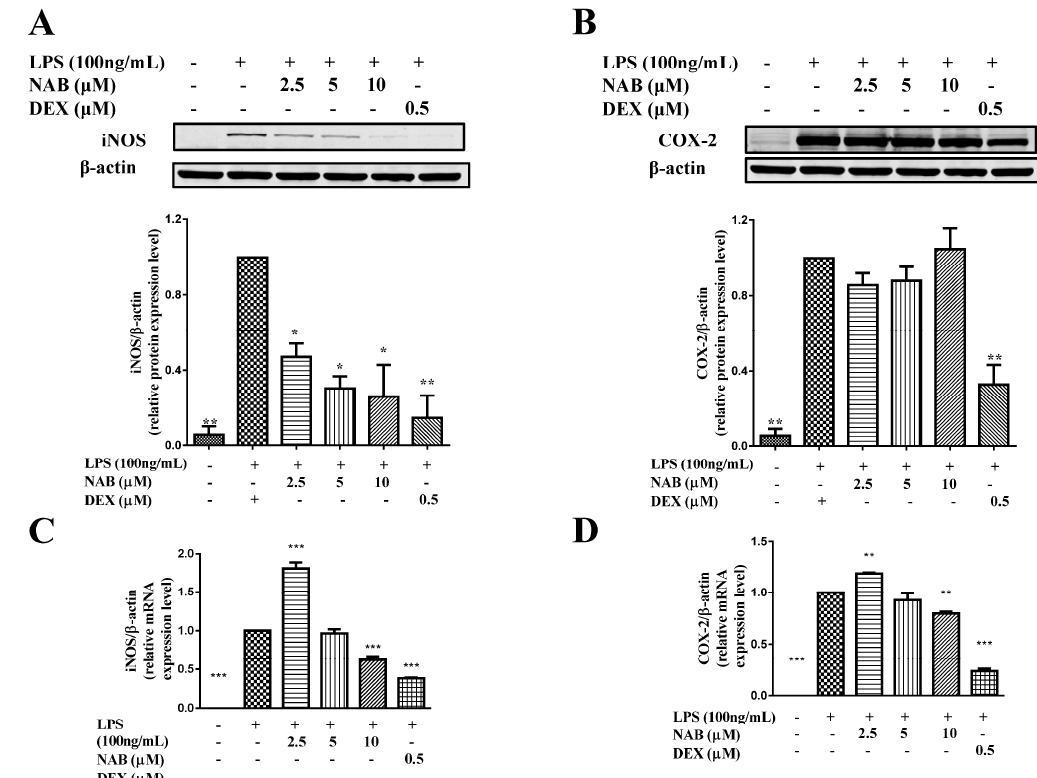
Figure 3. The effect of NAB on the expression levels of inducible nitric oxide synthase (iNOS) and cyclooxygenase-2 (COX-2) in LPS-induced RAW264.7 macrophages. ( A and B ) Effect of NAB on the